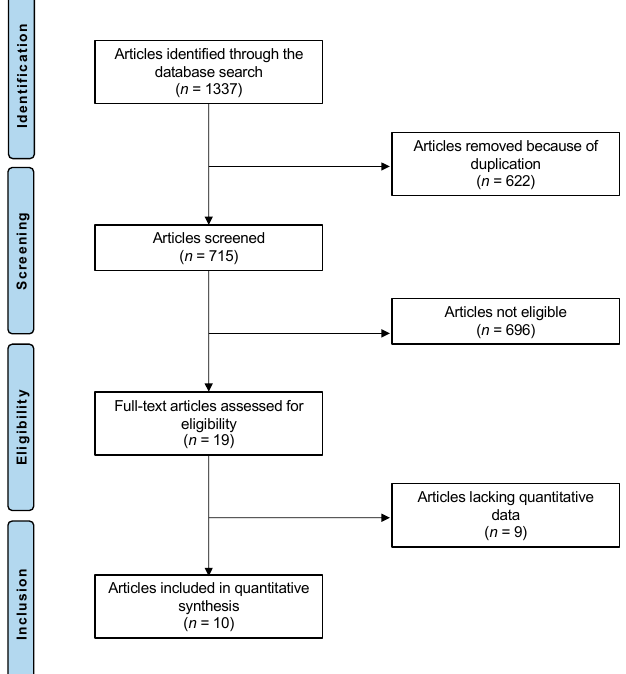
Figure 1. Flow chart of the literature search.